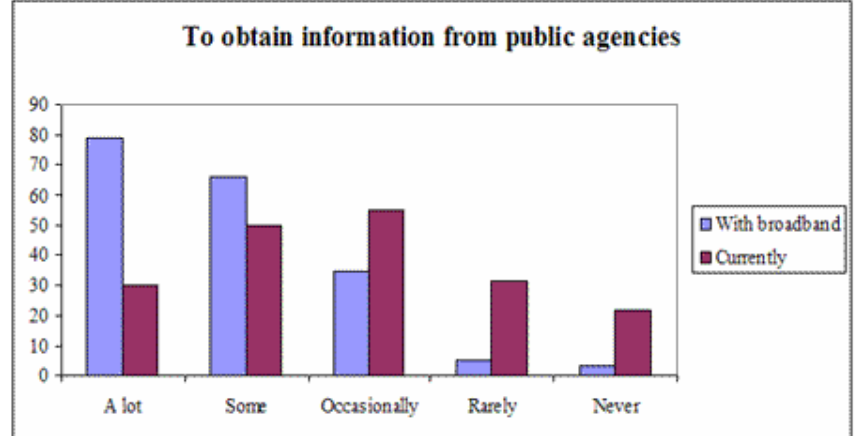
Figure 3. Respondents’ Current and Anticipated Use of the Internet to Obtain Information from Public Agencies